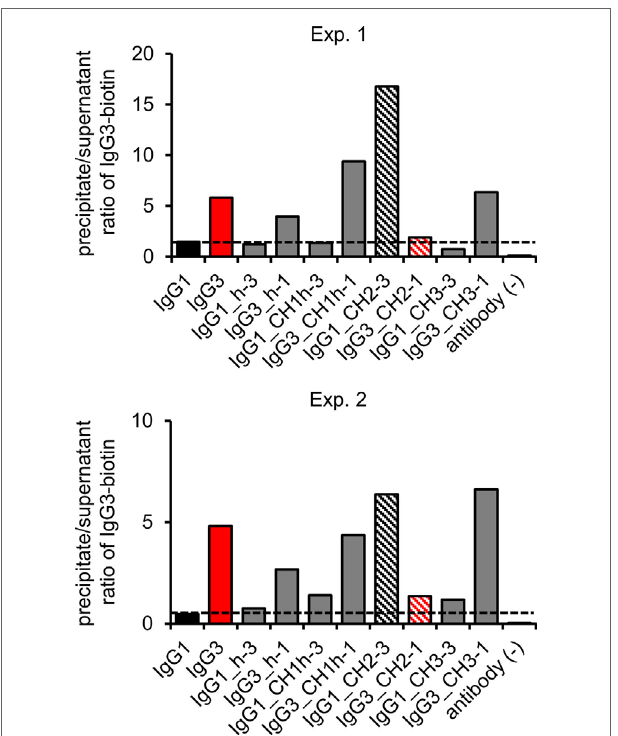
( Figure 4 ). Oligomerization did not depend on CH2 glycosyla­ tion (Figure S5 in Supplementary Material). The results indicate that the CH2 domain is crucial for oligomerization of